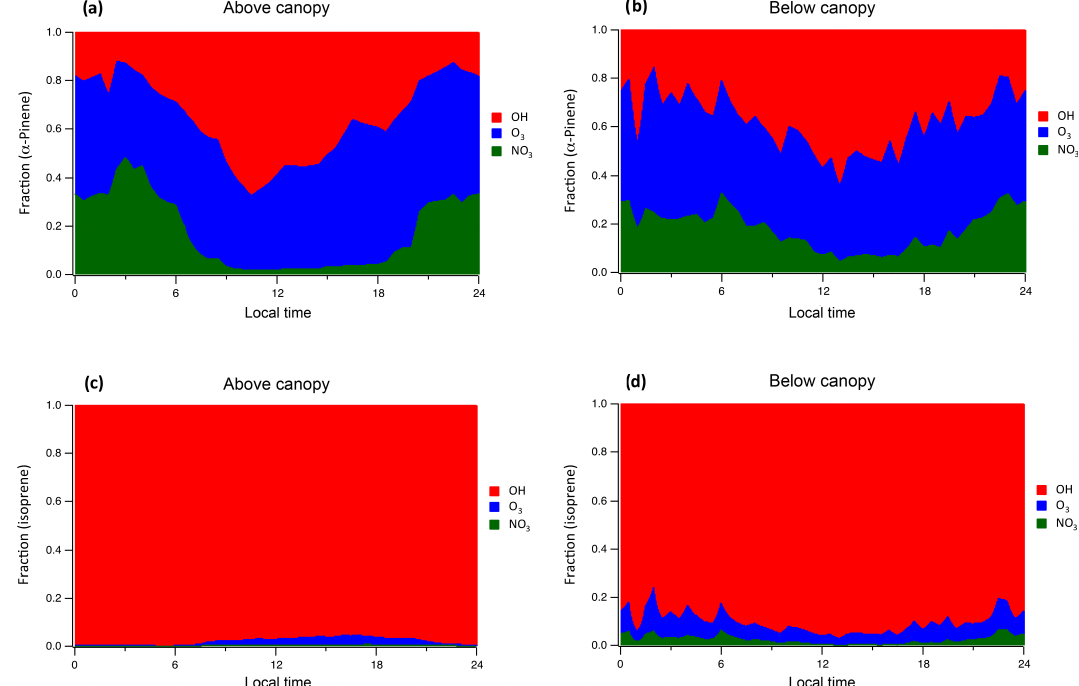
Figure 4. Modeled fractional contribution to oxidation rates of (a) α -pinene above canopy, (b) α -pinene below canopy, (c) isoprene above canopy, and (d) isoprene below canopy by OH, O 3 , and NO 3